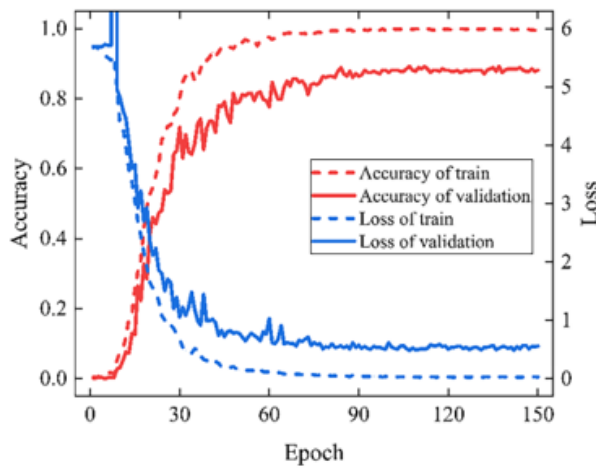
Figure 17. Training process of feature extraction network.